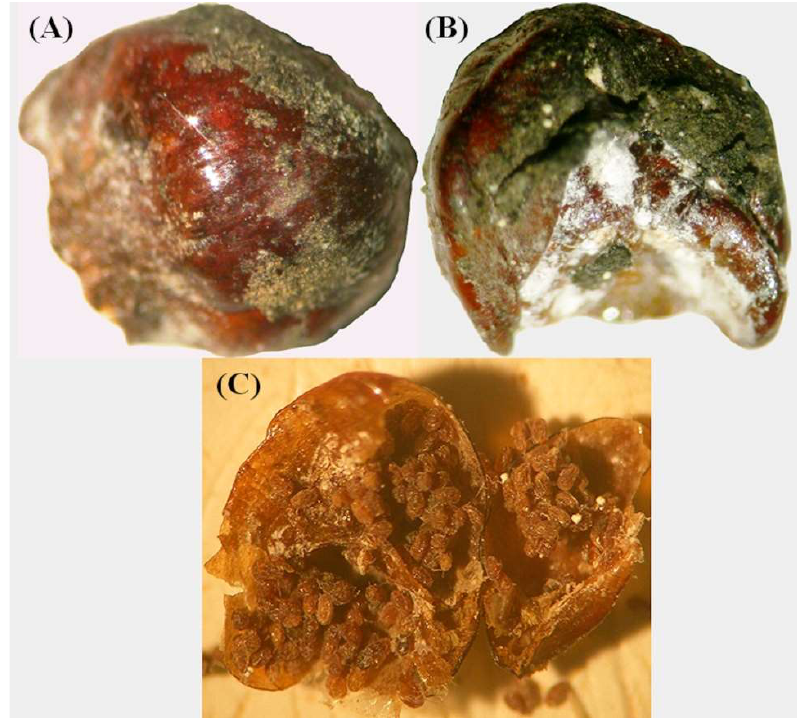
Figure 4. Dead-rotten adult female P. hellenicus with fungus on its surface: ( A ) dorsal view, ( B ) ventral view and ( C ) dead eggs of P. hellenicus inside the dead body of P. hellenicus .